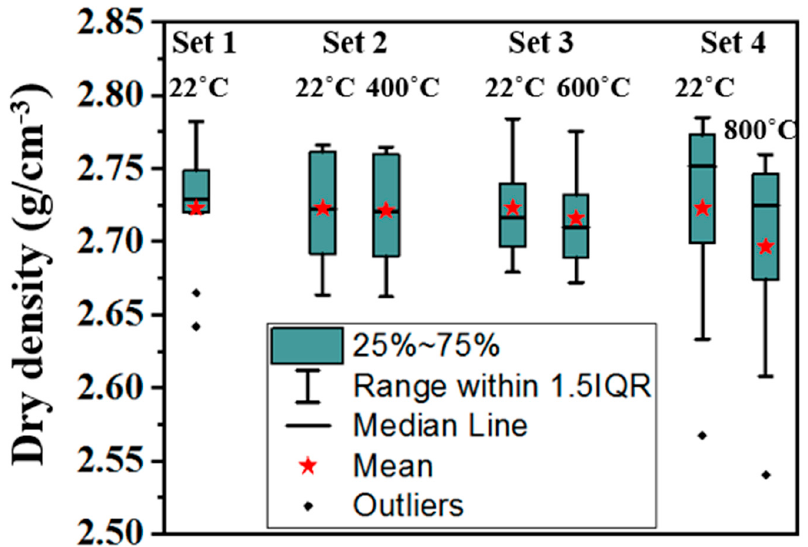
Figure 13. Results of the statistical analysis of dry density of the studied microschist samples (Set 1: S-0-1 to S-0-10, Set 2: S-1-1 to S-1-10, Set 3: S-2-1 to S-2-10, and Set 4: S-3-1 to S-3-10).